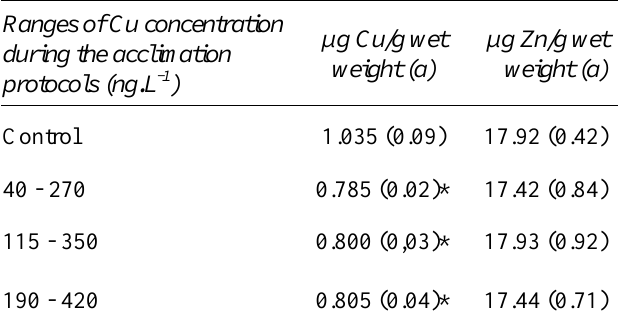
Table 1: Copper and zinc contents in Bufo arenarum embryos acclimated to